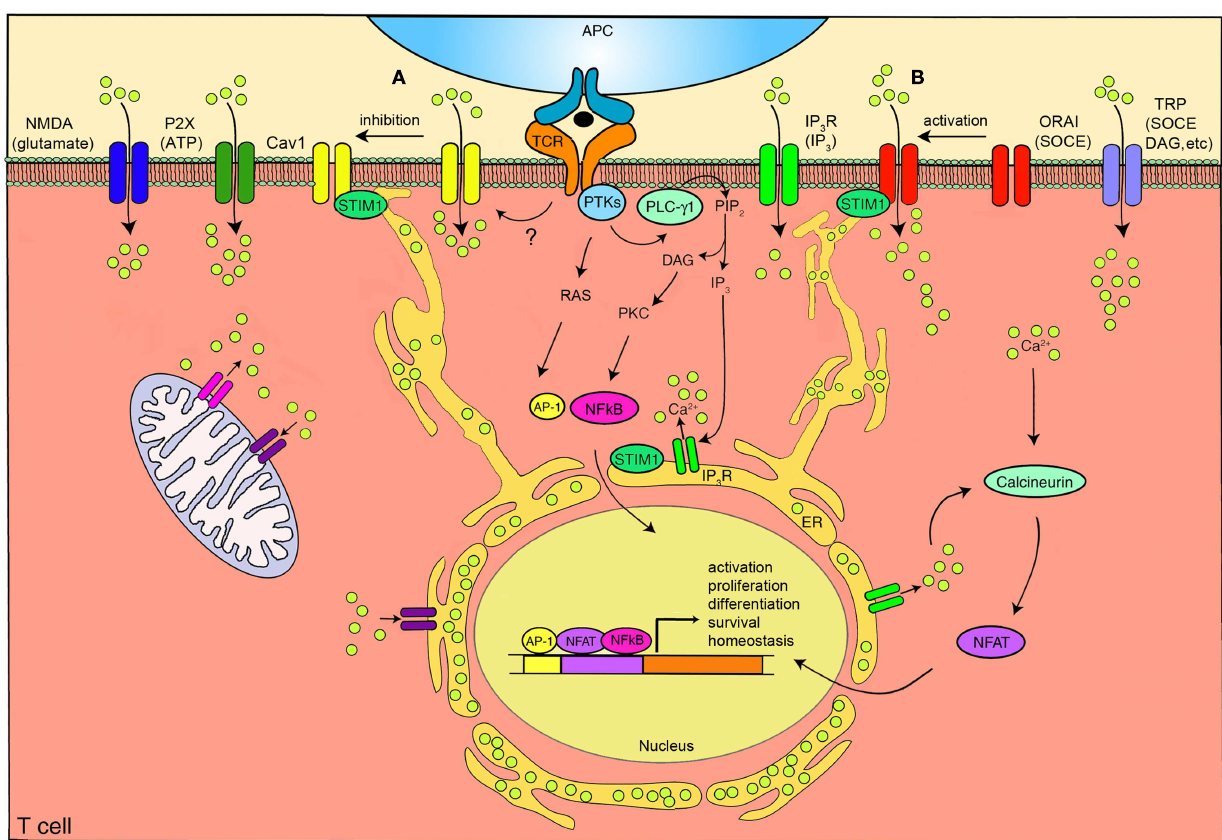
FIGURE 1 |The calcium channels inT cells .T cell receptor (TCR) engagement by a peptide-MHC on an antigen presenting cell (APC), induces protein tyrosine kinases (PTKs) to activate phospholipase C- γ 1 (PLC- γ 1), which cleaves phosphatidylinositol 4,5-bisphosphate (PIP 2 ) from plasma membrane phospholipids to generate diacylglycerol (DAG) and inositol-1,4,5-trisphosphate (IP 3 ). Elevated levels of IP 3 in the cytosol leads to the release of Ca 2 + from IP 3 R Ca 2 + channels located in the endoplasmic reticulum (ER). Ca 2 + depletion from the ER induces Ca 2 + influx from the extracellular space through the plasma membrane channel, ORAI1. Several auxiliary channels also operate duringTCR-mediated Ca 2 + signaling.These include plasma membrane IP 3 R activated by the ligand IP 3 , transient receptor potential (TRP) channels that can be operated by DAG and store-operated Ca 2 + entry (SOCE), adenosine triphosphate (ATP) responsive purinergic P2 (P2X) receptors, glutamate mediated N -methyl-D-aspartate activated (NMDA) channels, and voltage-dependent Ca 2 + channels (Ca V 1) that may be regulated throughTCR signaling events. The mitochondria also control cytoplasmic Ca 2 + levels. Increase in intracellular Ca 2 + results in activation of calmodulin-calcineurin pathway that